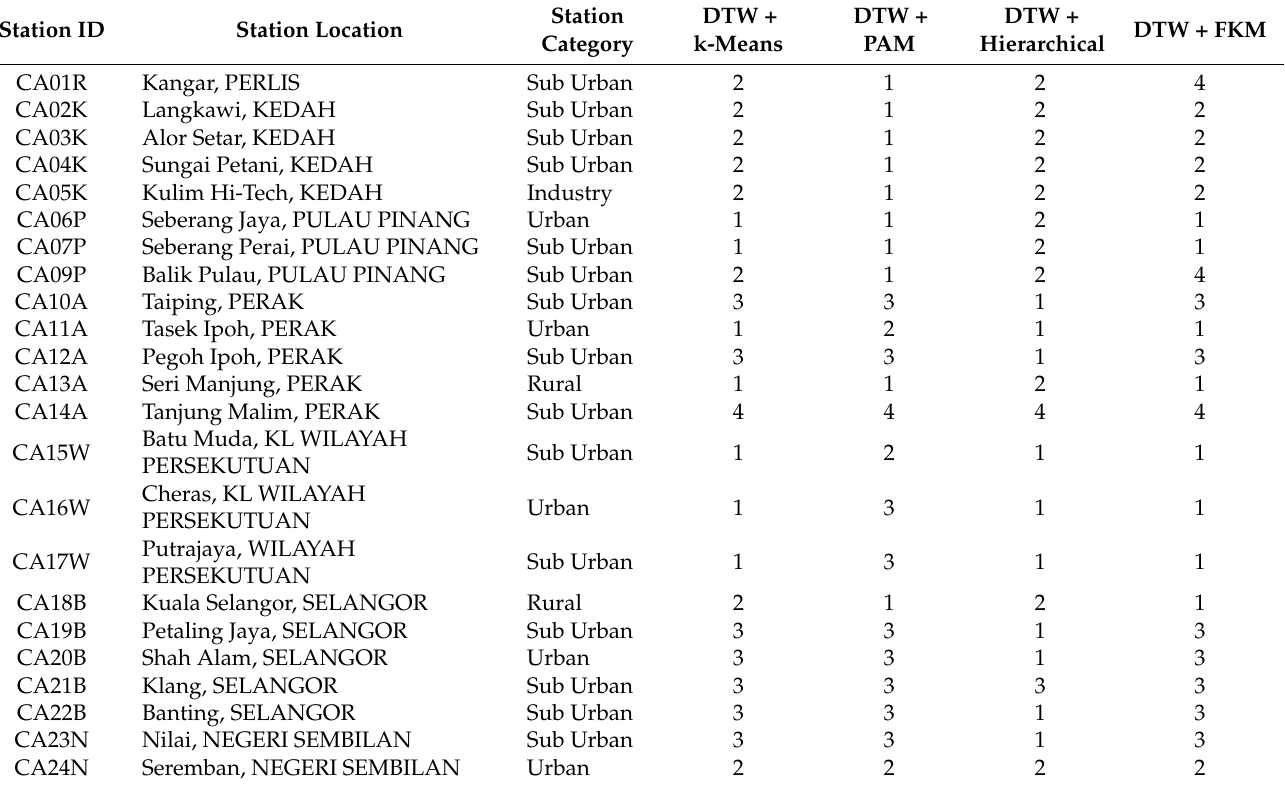
Table 2. Cluster membership for PM 10 daily average data according to stations based on four clustering